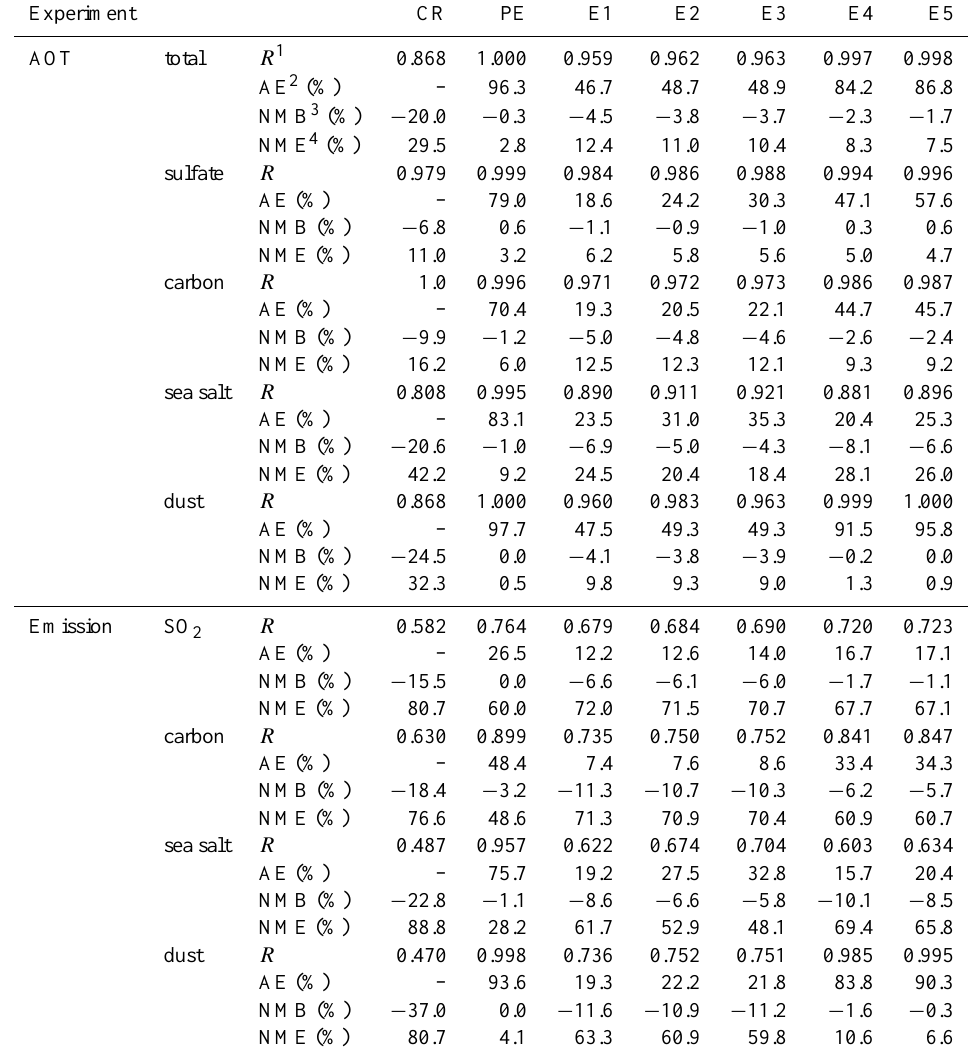
Table 6. Statistics of the six experiments versus the control run (CR) for aerosol optical thickness and emissions. All statistics were calculated between 60 ◦ S and 70 ◦